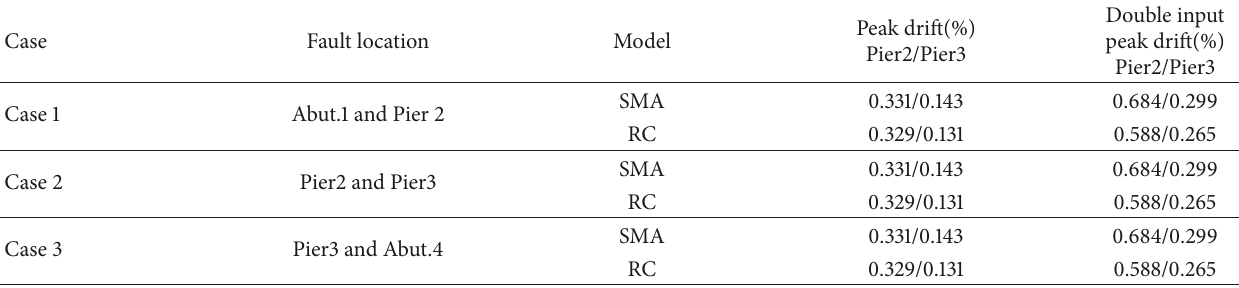
Table 4: Peak drift results of fault-rupture study in the longitudinal direction (%).